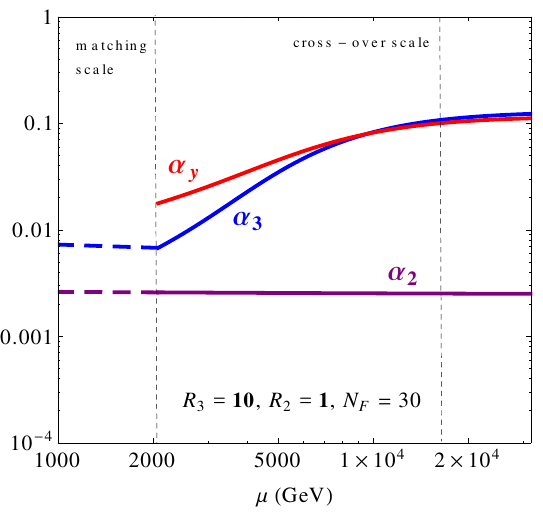
Figure 7 . Low scale matching from the partially interacting (cid:12)xed point FP 3 onto the SM for the benchmark scenario B with ( R 3 ; R 2 ; N F ) = ( 10 ; 1 ; 30) and M = 2 TeV. BSM (SM) running is shown by full (dashed) lines. Around the cross-over scale the BSM running of (cid:11) 3 and (cid:11) y slows down from power-law to logarithmic. Notice that the running of the weak coupling is not modi(cid:12)ed by the BSM